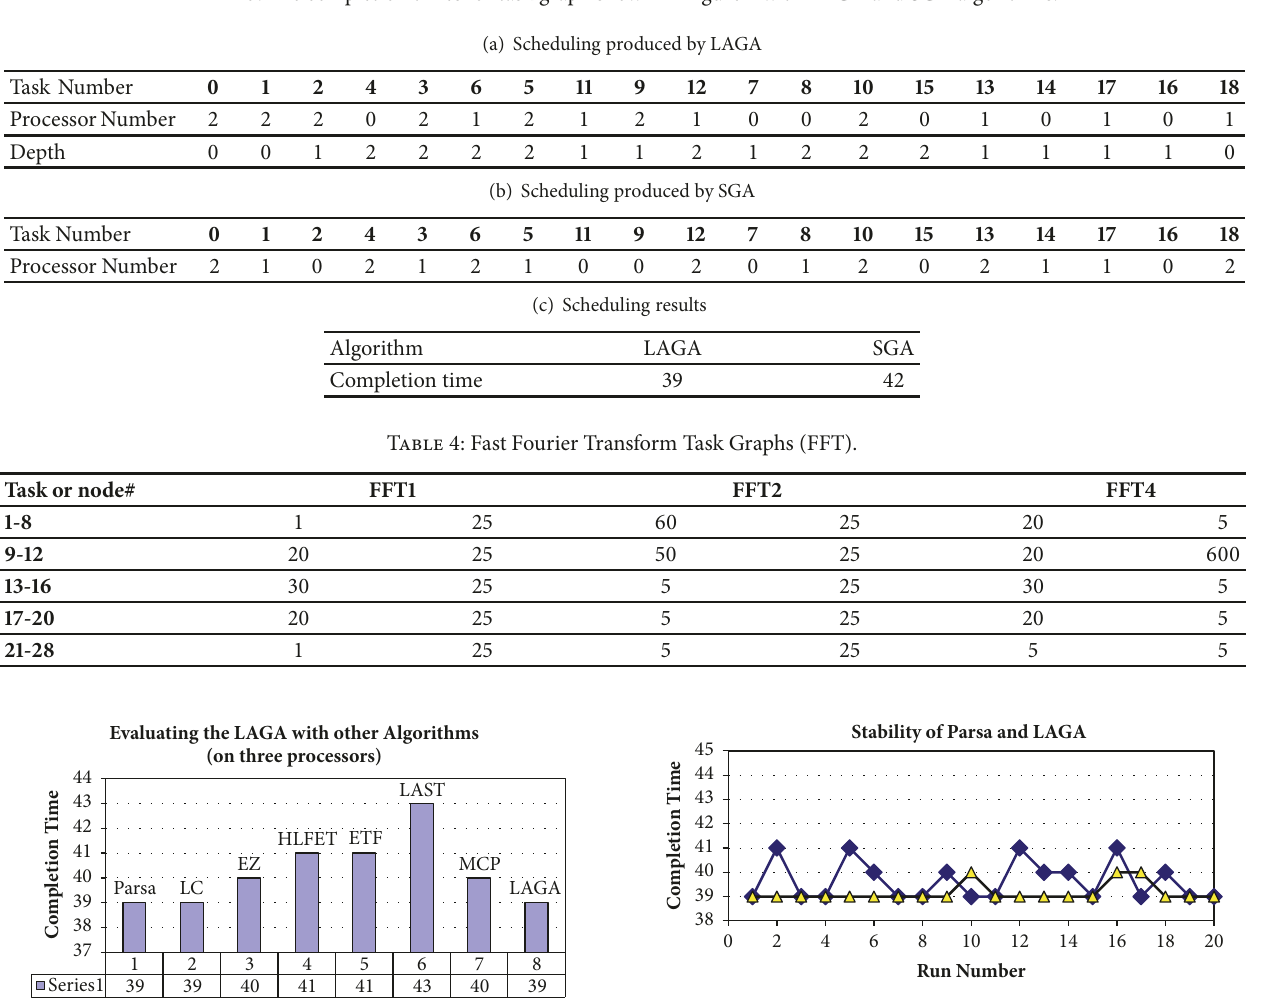
Table 3: The completion times for task graph shown in Figure 4 with LAGA and SGA algorithms.